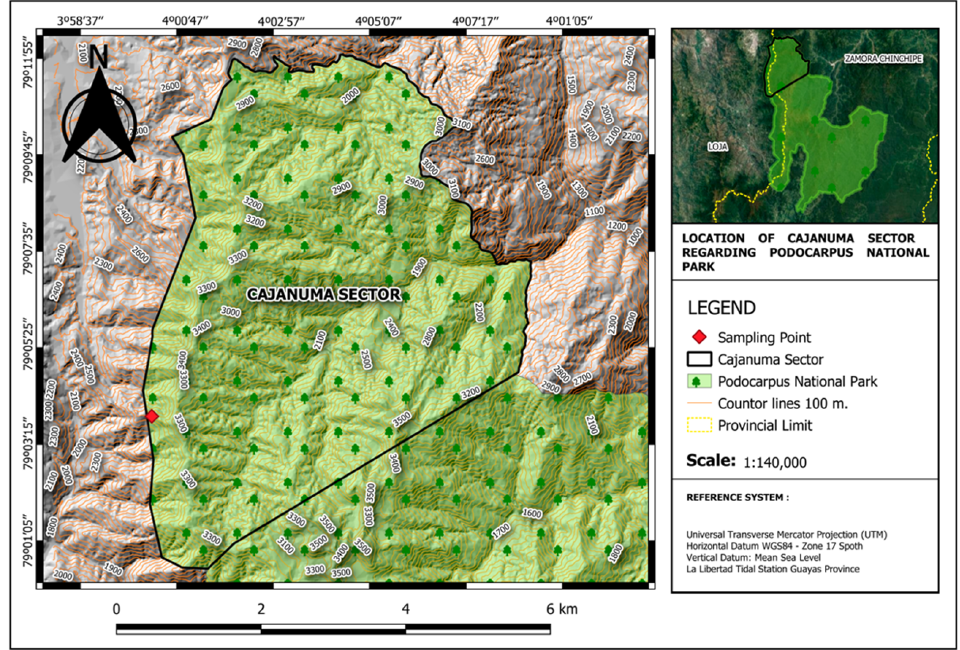
Figure 1. Location of sampling area in Cajanuma within the Podocarpus National Park (PNP); located in the provinces of Loja and Zamora Chinchipe, Ecuador.